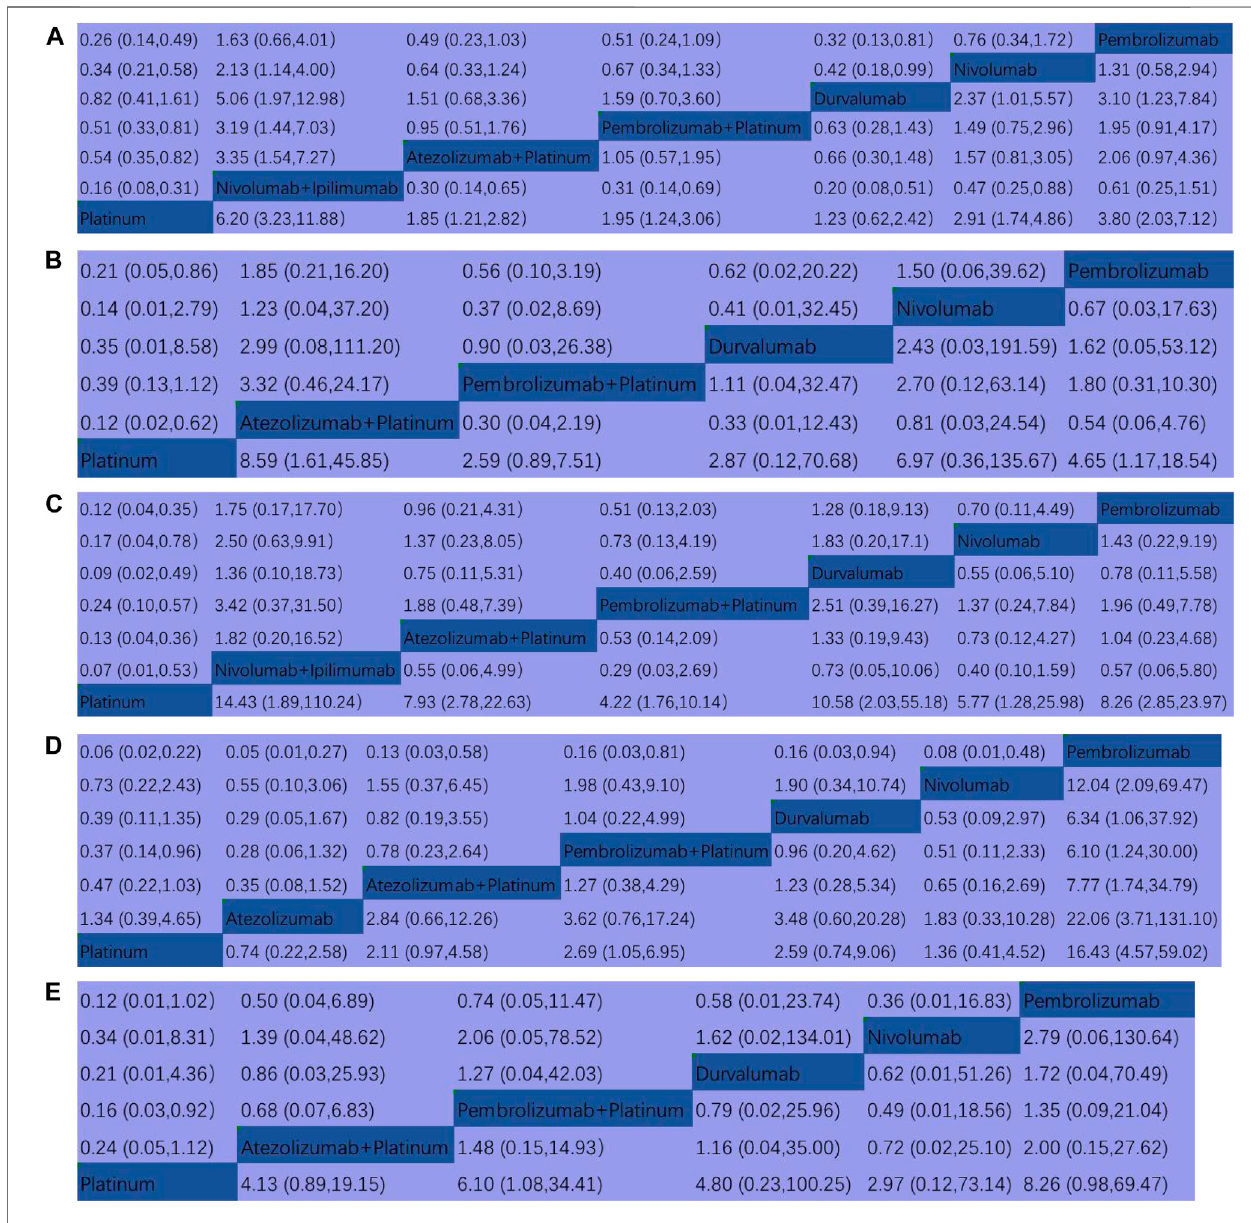
FIGURE 4 | Pooled estimates of the network meta-analysis. (A) Multiple treatment comparison for dermatologic irAEs based on network consistency. (B) Multiple treatmentcomparison forcolitisbasedonnetworkconsistencymodel. (C) Multipletreatmentcomparison forendocrineirAEsbasedon networkconsistencymodel. (D) Multiple treatment comparison for pneumonitis based on network consistency model. (E) Multiple treatment comparison for hepatitis based on network consistency model. (OR ＞ 1 means the treatment in top left is worse; Platinum (cid:1) Platinum based chemotherapy).